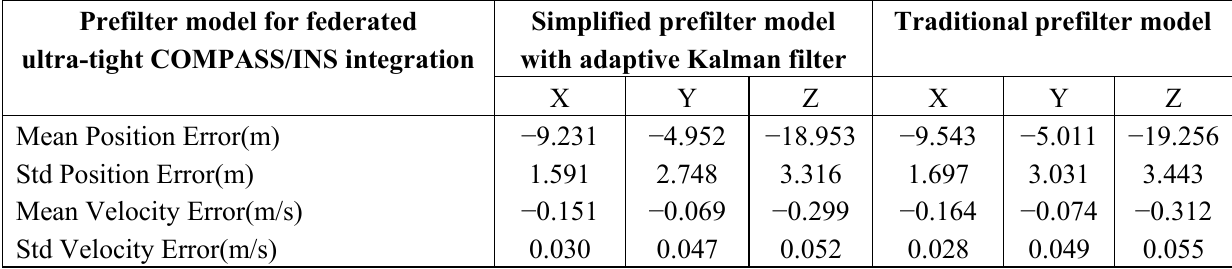
Table 6. Statistics of position and velocity errors in ECEF frame with different prefilter